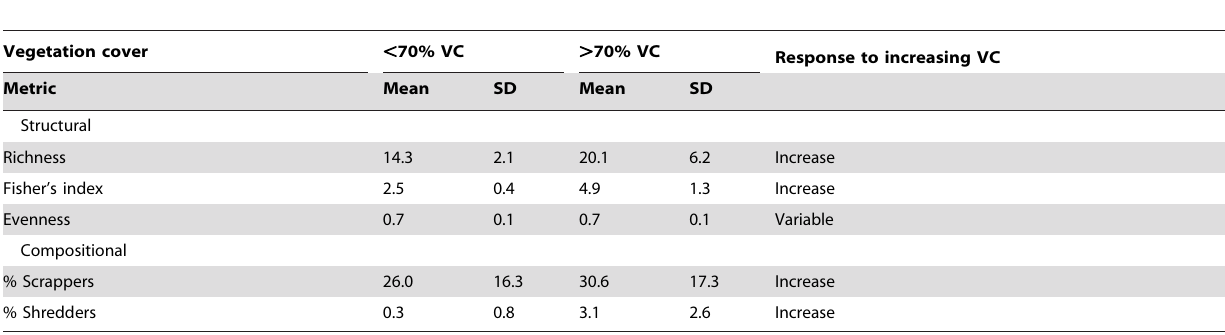
Table 3. Diversity patterns of macroinvertebrate communities in both groups of catchments identified in RDA ordination plot (Figure 3B). VC = catchment vegetation